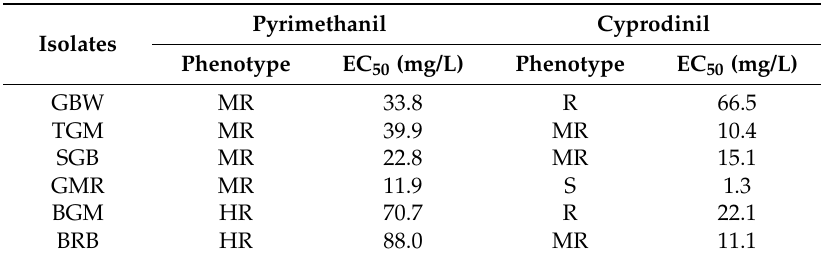
Table 1. Sensitivity of Botrytis cinerea isolates to pyrimethanil and